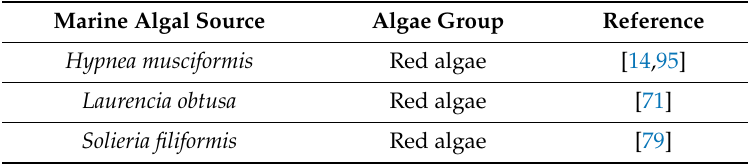
Table 9. Marine algae source with gastroprotective activity attributed to